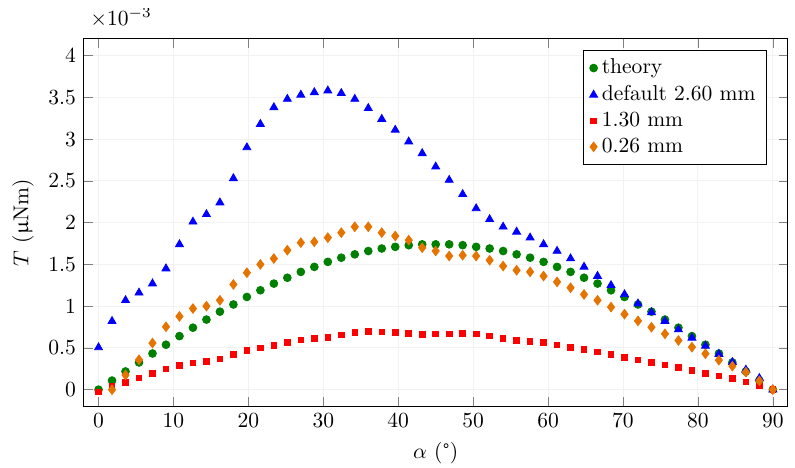
Figure 7. The effect of computation maximum mesh size.